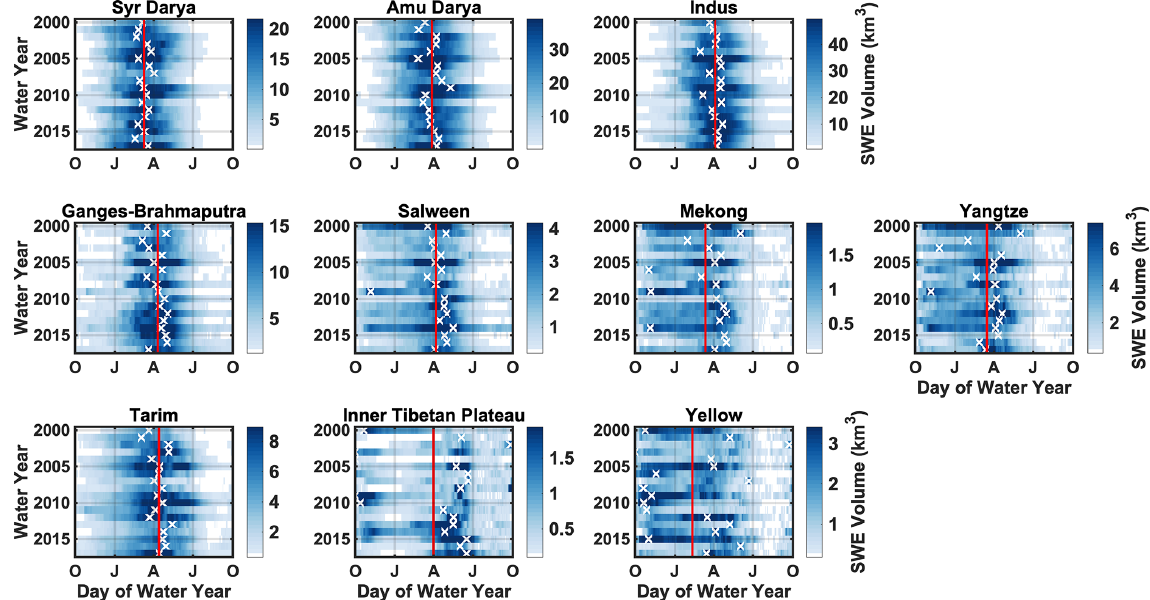
Figure 9. Daily time series of basin-scale SWE volumes displayed as functions of DOWY and WY. The symbol “x” is used to mark the date of basin-scale peak SWE volume occurrence in each WY. The vertical red line is used to indicate the 18-year average timing of basin-scale peak SWE